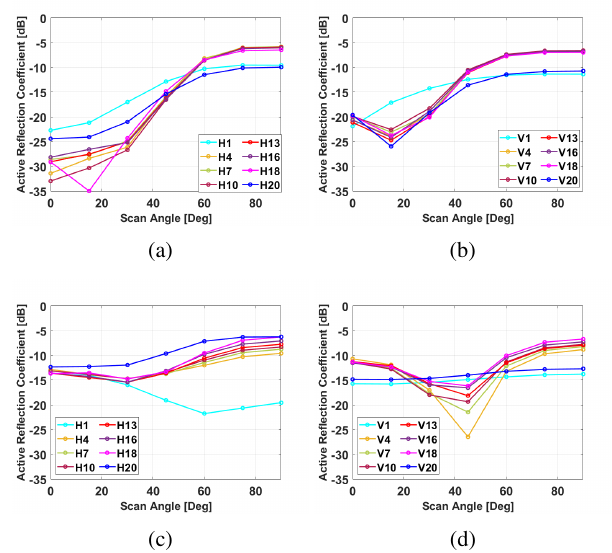
FIGURE 9: Active S-Parameters for some of the (a) H and (b) V Ports at d=0.5 λ and for (c) H and (d) V Ports at d=0.4 λ of a 2X20 Array at